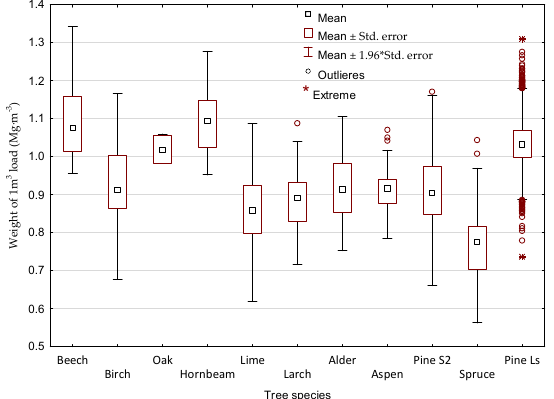
Figure 12. Statistical characteristic of weight of 1 m 3 load by tree species. (Pine S2—for medi- um-sized pine loads; pine Ls—large-sized pine loads). pine loads; pine Ls—large-sized pine